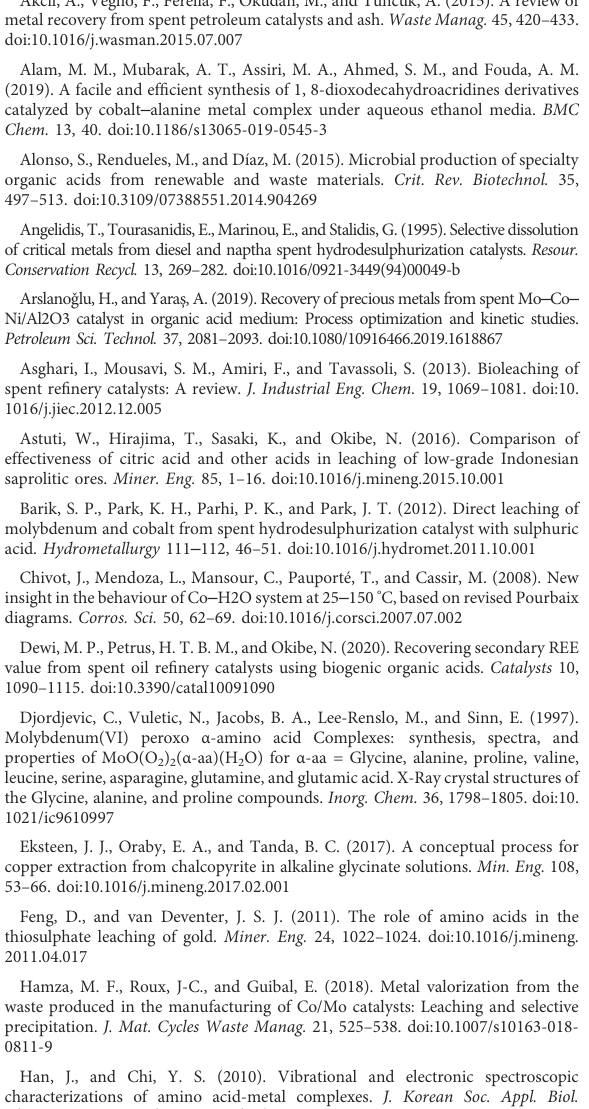
SUPPLEMENTARY FIGURE S1 Pourbaix diagram for Molybdenum — H 2 O system. (cid:1) Mo = 10 − 5 M at 25 ° C (Lyon, 2010). SUPPLEMENTARY FIGURE S2 Pourbaixdiagramfor Cobalt — H 2 Osystem. (cid:1) Co=10 − 6 Mat25 ° C(Chivot et al., 2008).